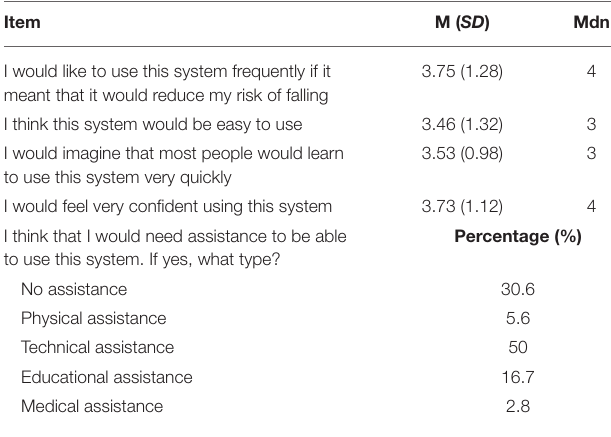
TABLE 3 | Means (standard deviations), medians, and percentage of the responses to a modified version of the SUS questionnaire.